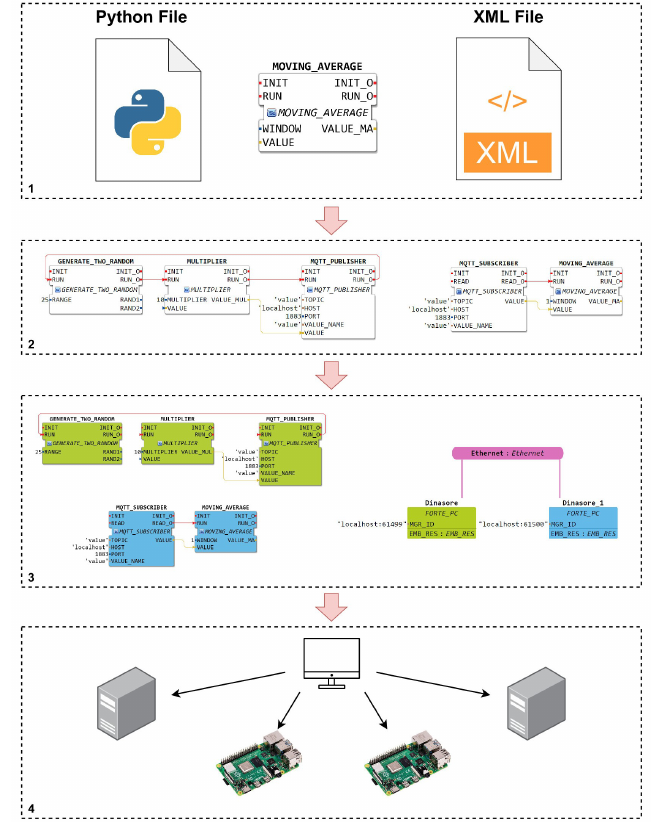
Figure 1. 4diac IDE and DINASORE—Development